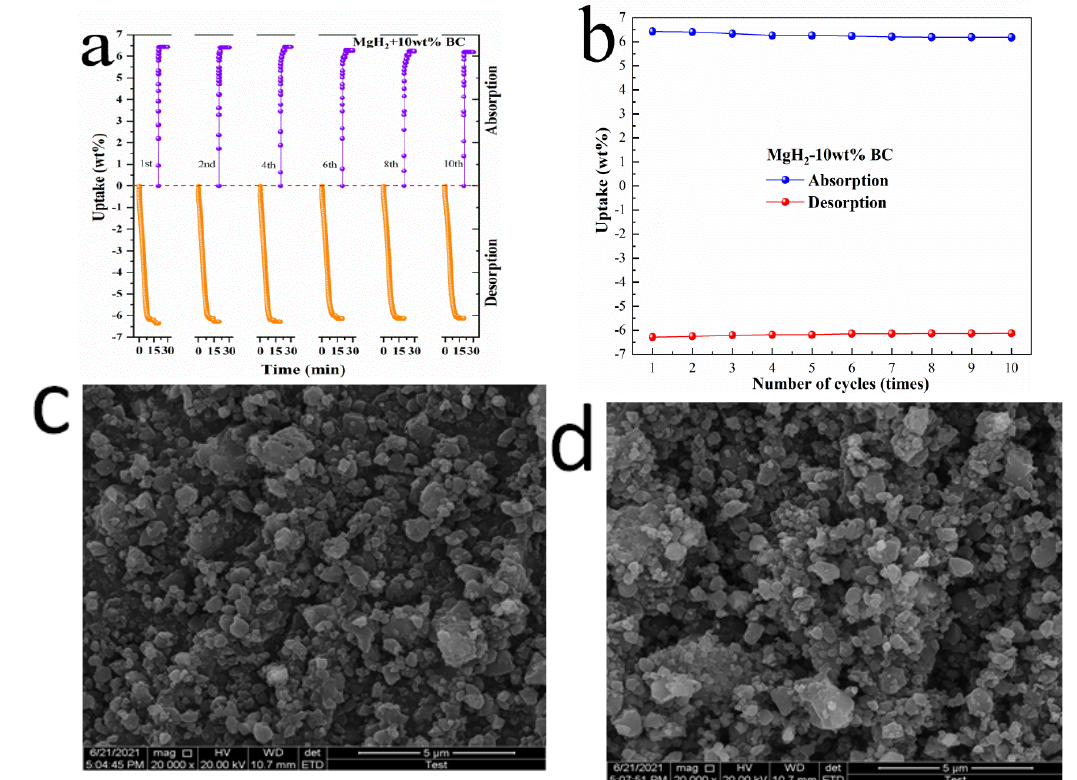
Figure 5. Hydrogen absorption and desorption cycle curves of ( a ) MgH 2 + 10 wt% BC and at 350 °C. Curves showing the ( b ) hydrogen storage capacity of the system and the discharge over a number of cycles. SEM images of ( c ) MgH 2 + 10 wt% BC after ball-milling and ( d ) MgH 2 + 10 wt% BC after the 10th hydrogen absorption.